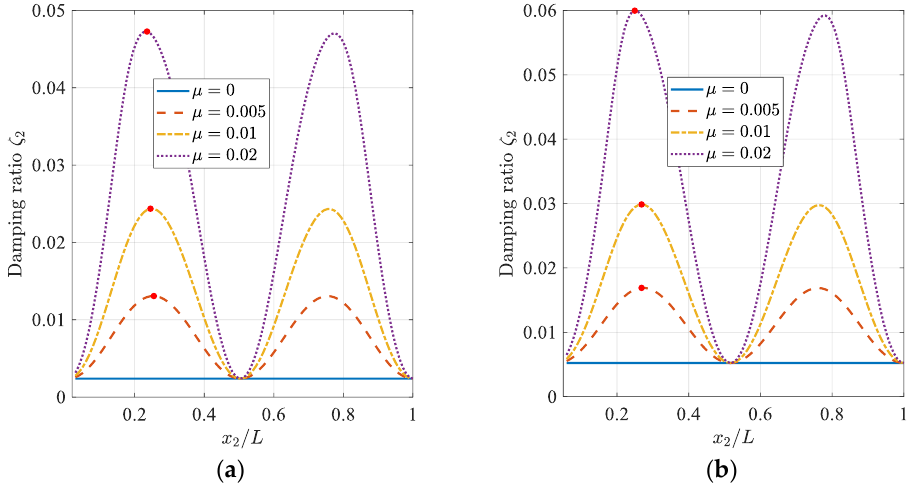
Figure 9. Second modal damping of a cable with two dampers versus the TM-HDR-D location x 2 / L ( ϕ = 0.5, ρ = 0.5), with ( a ) x 1 / L = 0.02 and ( b ) x 1 / L = 0.05.